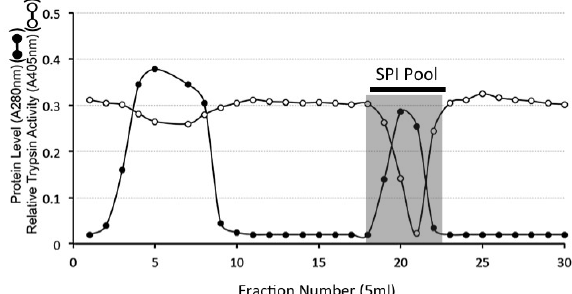
Figure 2. Hyaluronan (HA) affinity chromatography of the serine proteinase inhibitor (SPI) pool from DEAE Anion exchange chromatography of the ovine AC SPIs. The column was eluted with 2 bed volumes of starting buffer 50 mM Tri-HCl pH 7.2 and the bound SPI eluted by a step change elution with 2 M NaCl in starting buffer. Fractions containing trypsin inhibitory activity were pooled (SPI pool) for further analysis.